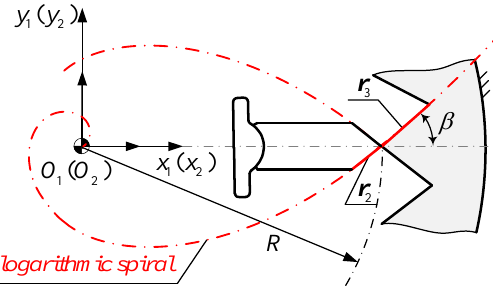
Figure 6. Logarithmic spiral conjugate tooth profiles.